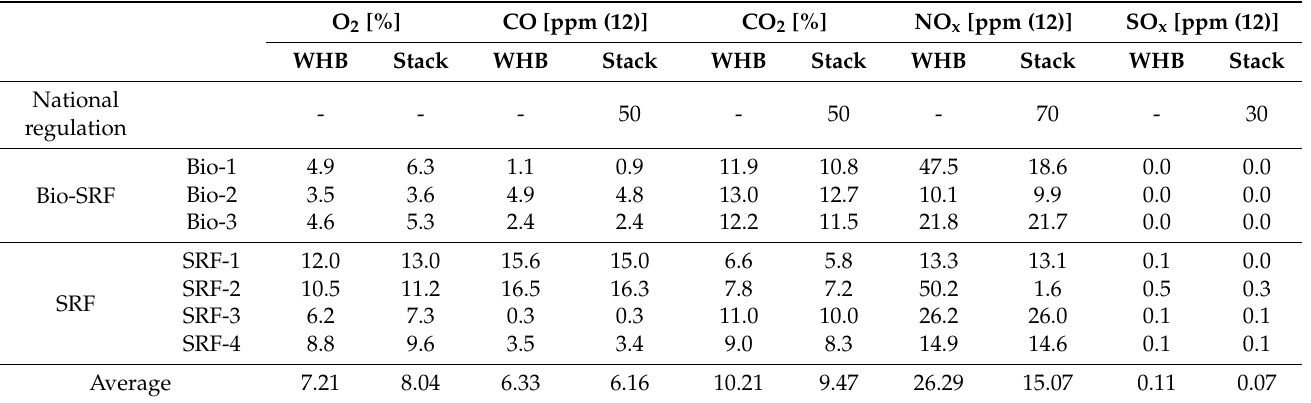
Table 4. Concentration of air pollutant materials in WHB and